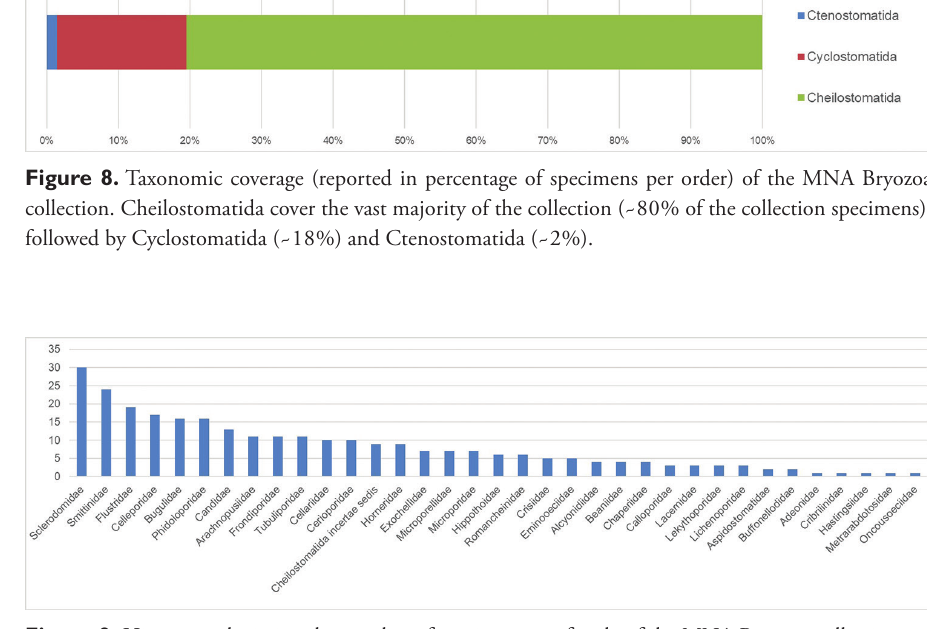
Figure 9. Histogram depicting the number of specimens per family of the MNA Bryozoa collection.